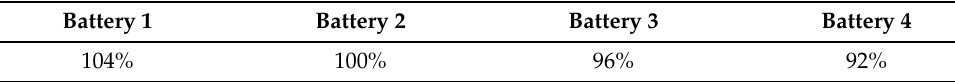
Table 6. Initial values of the battery capacities related to the rated